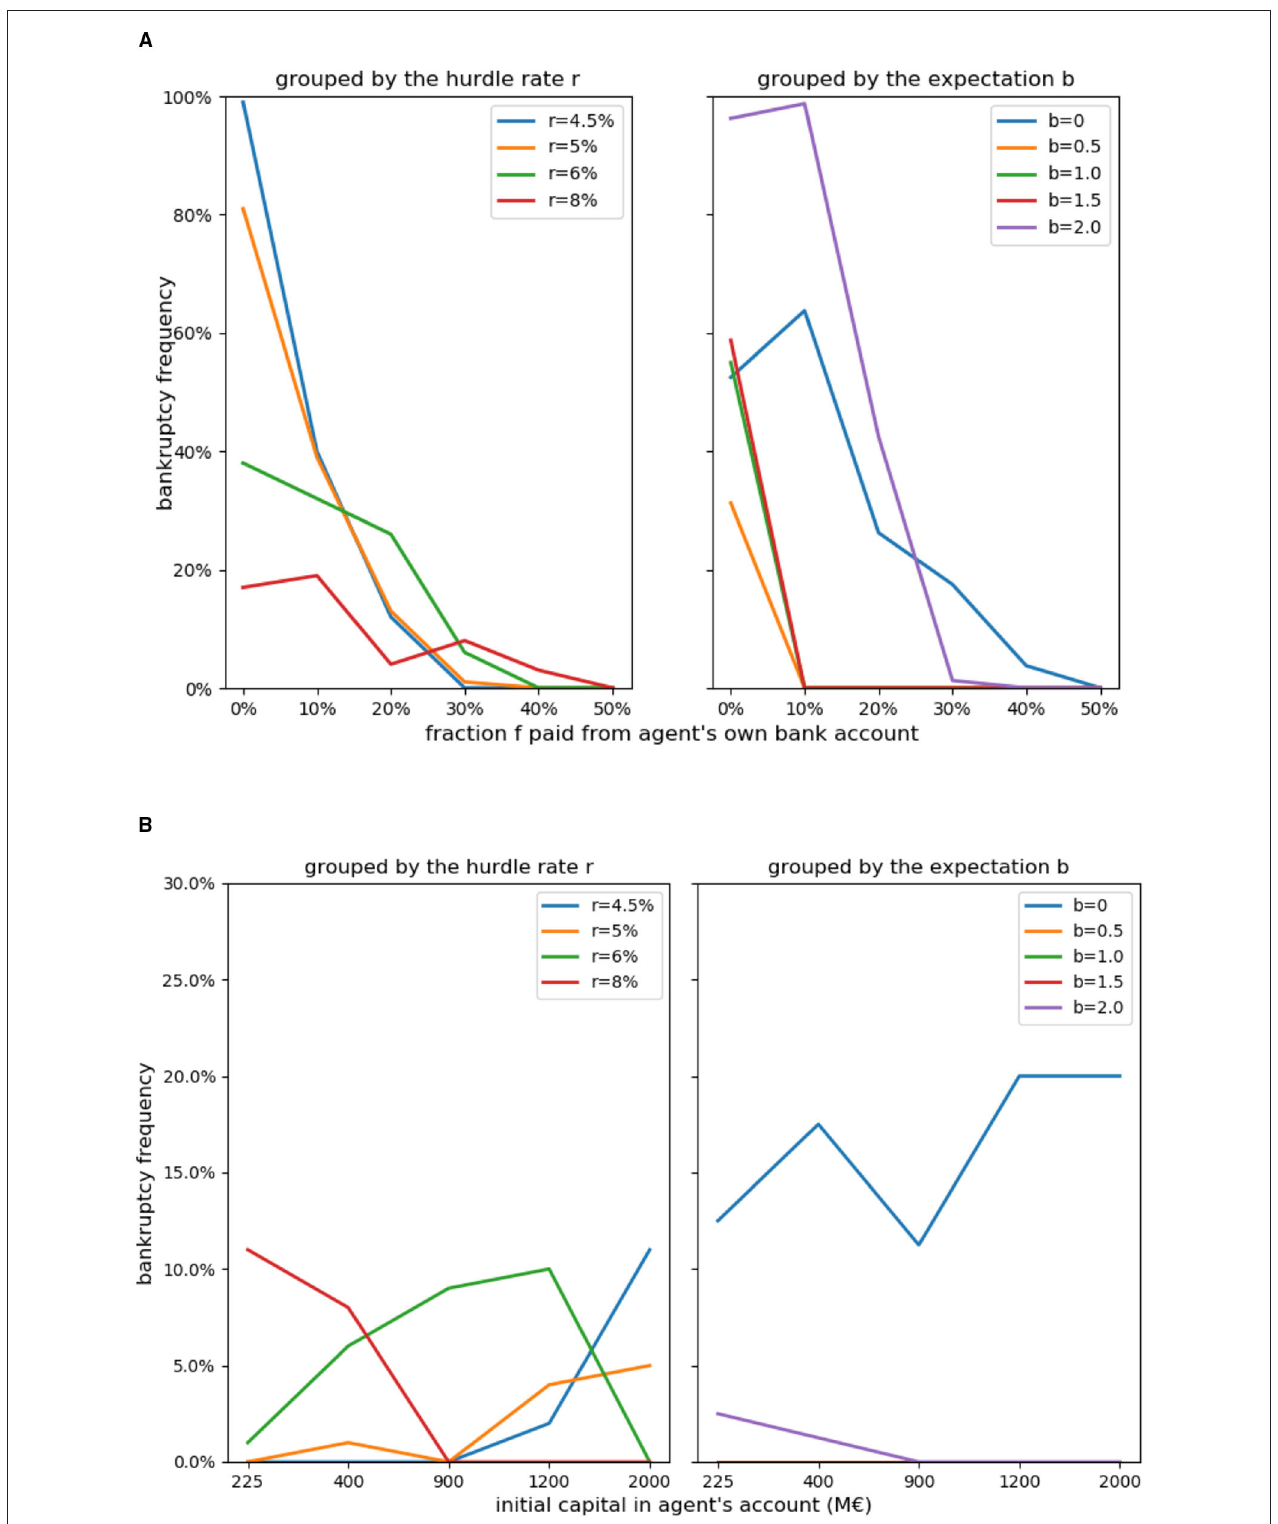
FIGURE 10 | Bankruptcy frequency of agents grouped by hurdle rate r or carbon tax expectation b. (A) Cases with varying f , which is the fraction of an investment financed by a company’s own capital; (B) cases with varying i , which is the initial capital in a company’s bank account.